Question: Generate an informative caption for the figure above.
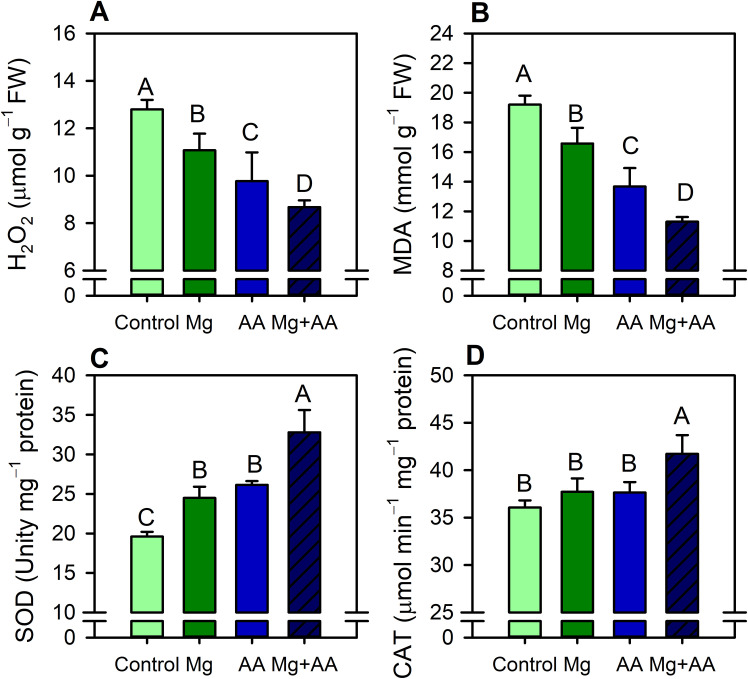
Answer: Concentrations of (a) hydrogen peroxide (H 2 O 2 ), (b) malondialdehyde (MDA), (c) superoxide dismutase (SOD), and (d) catalase (CAT) in maize leaves as affected by the foliar application of magnesium (Mg) and/or amino acids. Bars represent the mean values from the 2021 and 2022 harvests conducted in Botucatu-SP, Brazil. Bars with different letters are significantly different according to the LSD test ( p < 0.05). The error bars indicate the standard deviation ( n = 8).